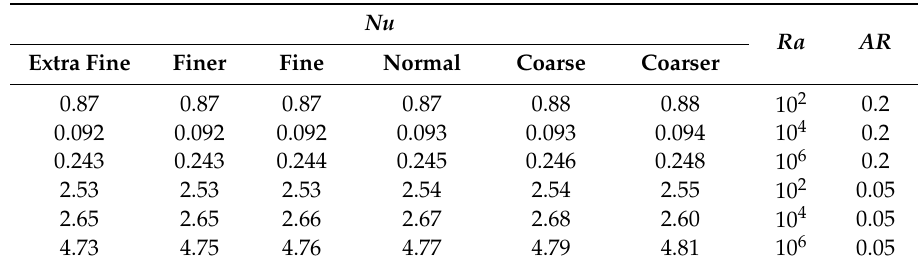
Table 5. The results of examining the independence of the network in terms of ϕ = 0.04, Ha = 40, and α =